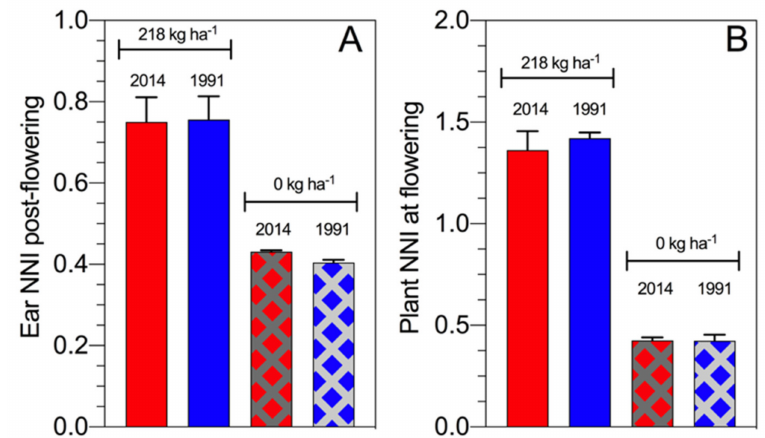
Figure 9. Ear NNI post flowering (including six sampling times during the reproductive period) (panel A ) and plant NNI at flowering time (panel B ) for two maize hybrids released in 2014 versus 1991 with full N fertilization and a control (Fernandez and Ciampitti, 2019)